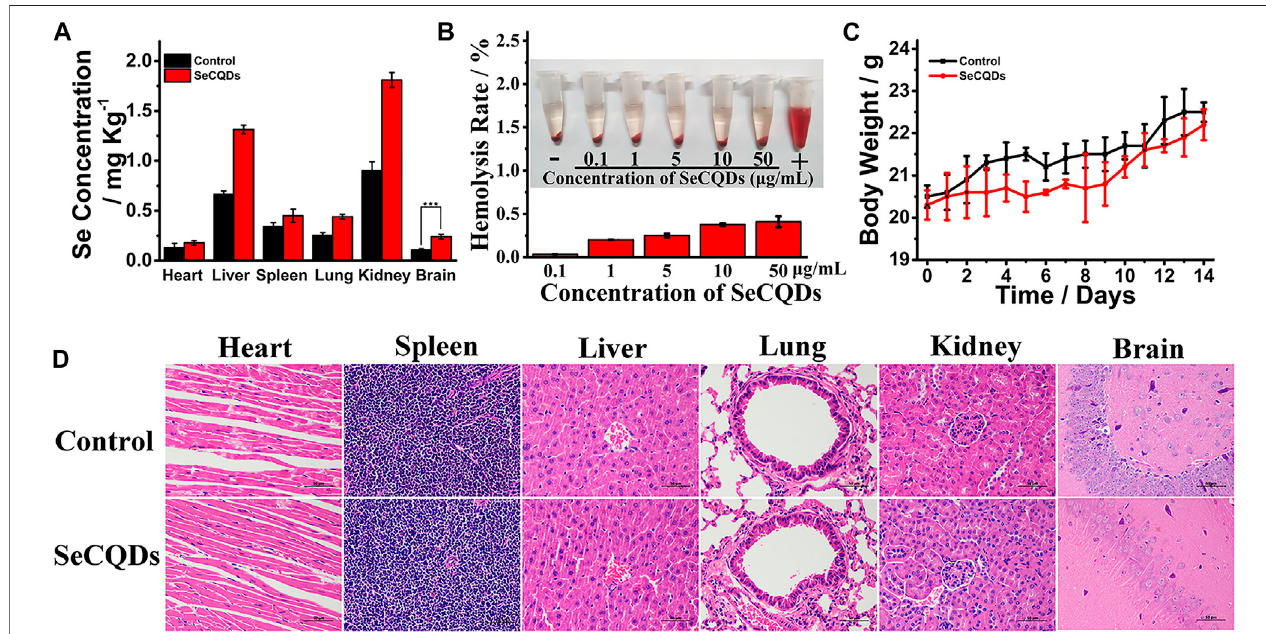
FIGURE7 | The biodistribution and biocompatibility ofSeCQDs. The biodistribution ofSeCQDsin healthy mice at 6 h after i. v. injection based on ICP-MS analysis (A) . Hemolytic assays for SeCQDs. The RBCs were collected by centrifugation of heparin-stabilized mice blood samples (B) . The concentration of SeCQDs varied from 0.1 μ g ml − 1 – 50 μ g ml − 1 . PBS and water which incubated with the diluted RBC suspension were served as negative and positive controls, respectively. Relative body weight of healthy mice after the treatment of SeCQDs in 14 days (C) (Mean ± SD, n (cid:1) 3). In vivo long-term toxicology of SeCQDs. H&E images of major organs obtained from the mice after intravenous injection with SeCQDs at 14 days post-injection (D) . Scale bars are 50 μ m.